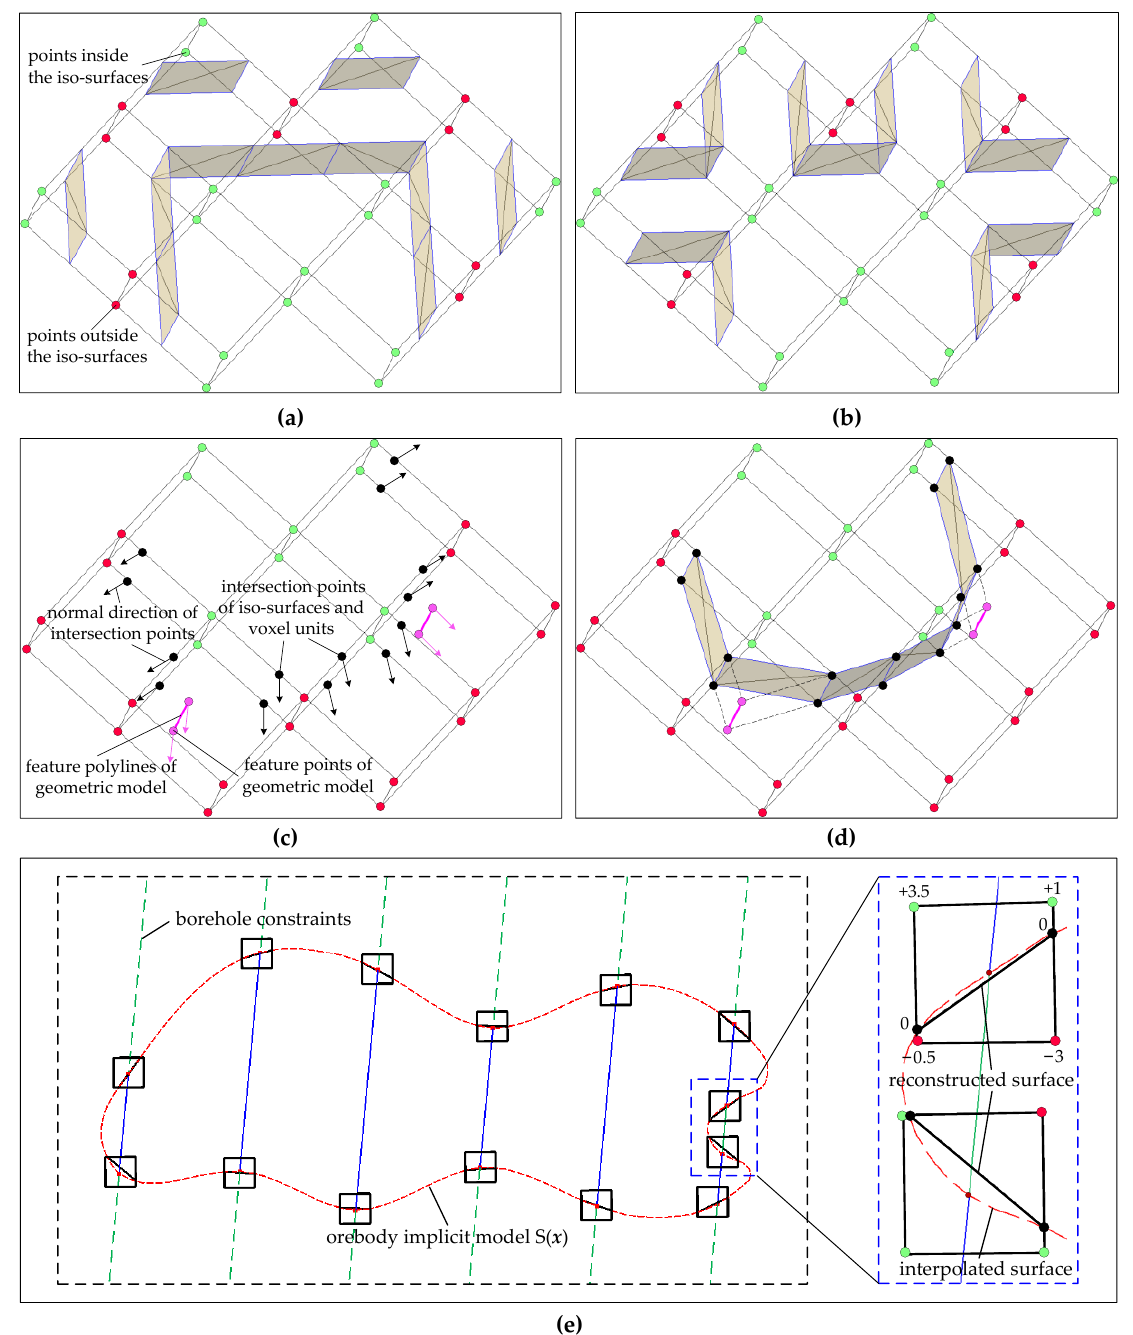
Figure 1. Reasons for inaccurate snapping in implicit surface reconstruction. ( a , b ) show the two different surface reconstruction results caused by ambiguity in the vertex state of the same voxel unit. ( c , d ) show the phenomenon of the loss of features after surface reconstruction due to the defects of the iso-surface extraction algorithm. ( e ) shows an example of implicit surface reconstruction of an orebody based on borehole